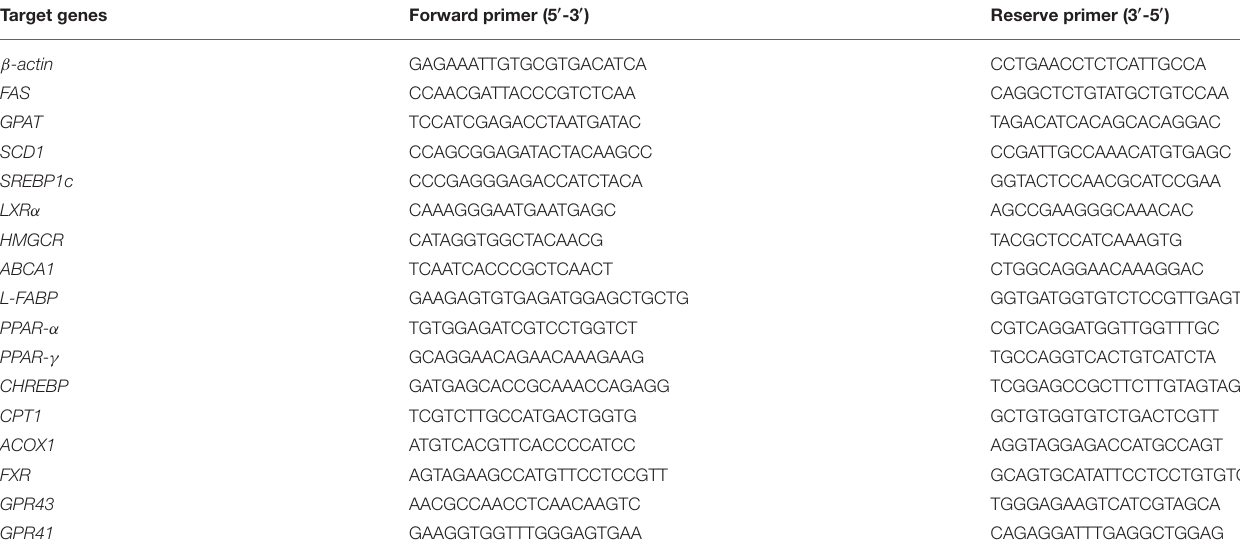
TABLE 3 | Primer sequence of target